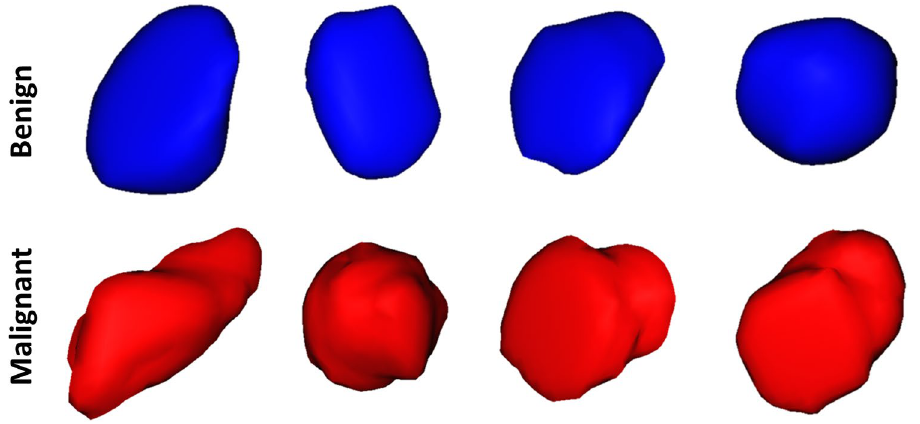
Figure 3. 3D visualization of the surface complexity differences between benign tumors (blue) and malignant ones